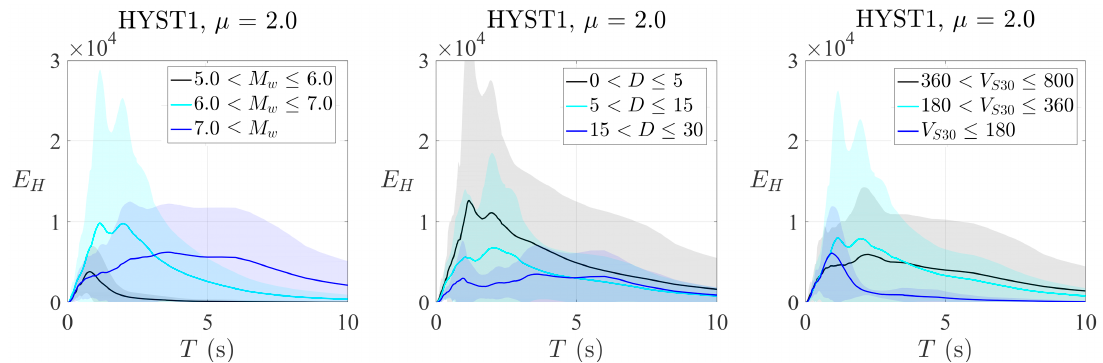
Figure 5. Spectra of the hysteretic energy dissipation demand E H for the hysteretic model HYST1 and ductility level μ equal to 2 considering different subsets of seismic records (filled area: envelope of the spectra; solid line: mean spectrum).